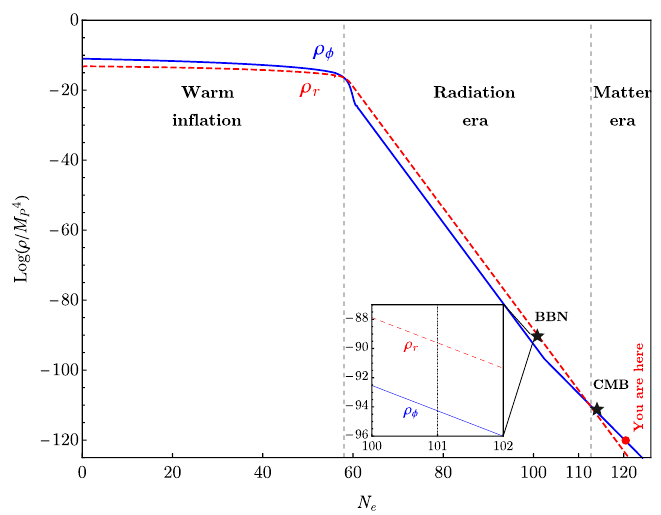
Figure 3 . Cosmological dynamics. The parameters are identical to those of figure 1. The dashed lines represent the two inflaton-radiation equalities. Big bang nucleosynthesis (BBN) ( T ∼ 1 MeV) and the last scattering surface (CMB) ( T ∼ 0 . 3 eV) are also highlighted. The inset shows a close-up of the energy densities during BBN, where f ≡ ρ φ /ρ r ∼ 10 − 5